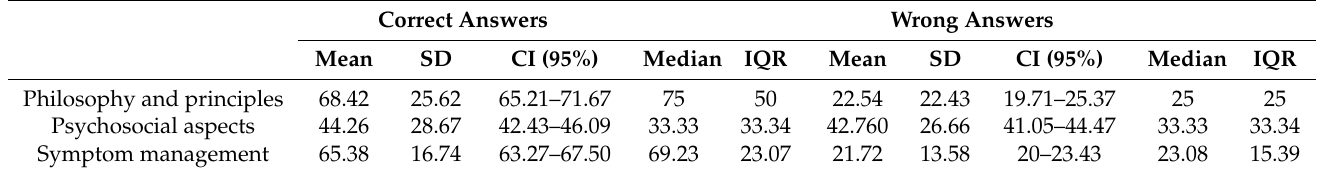
Table 3. Correct and wrong answers for each subscale of the questionnaire obtained studied population.